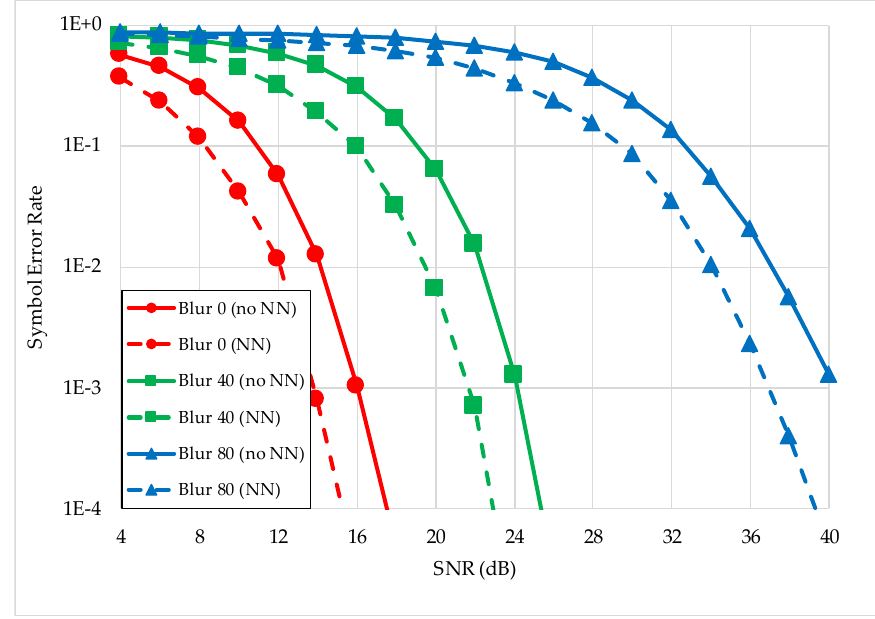
Figure 9. The decoding performance analysis of the matched filter and neural network-based decoder on blurred and noisy images (difference blur kernel, AWGN channel).